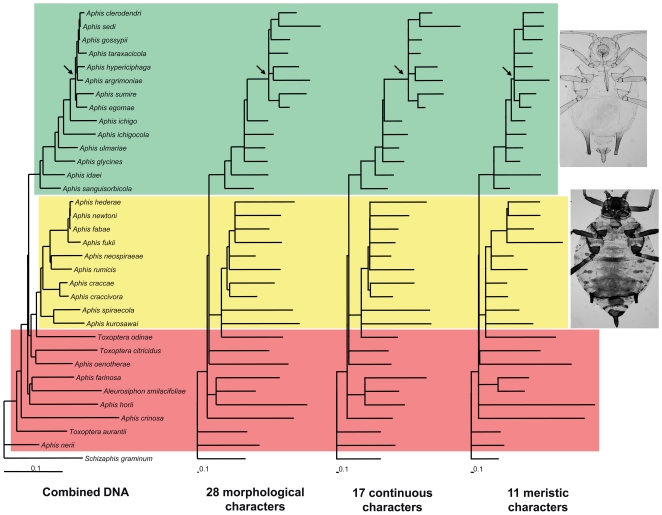
Comparison of branch lengths between the trees of combined DNA and three morphological datasets optimized with the topological constraint based on the ML tree (
Figure 1
).Arrow means a short divergence point in the gossypii group. Green background - gossypii group (typical morphology from A. glycines), yellow - craccivora + fabae + spiraecola groups (typical morphology from A. craccae), red - unclassified species.